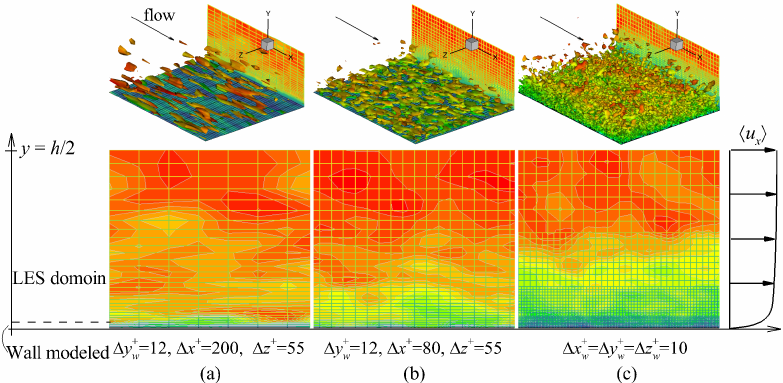
Figure 1. Turbulence structures in a channel flow at Re τ = 2320 based on three grid